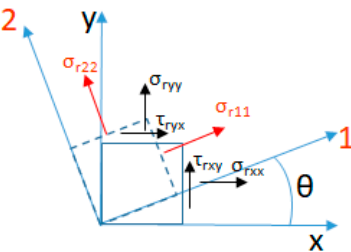
Figure 1. Residual stresses in the principal system (1, 2) and in the loading system ( x , y ).